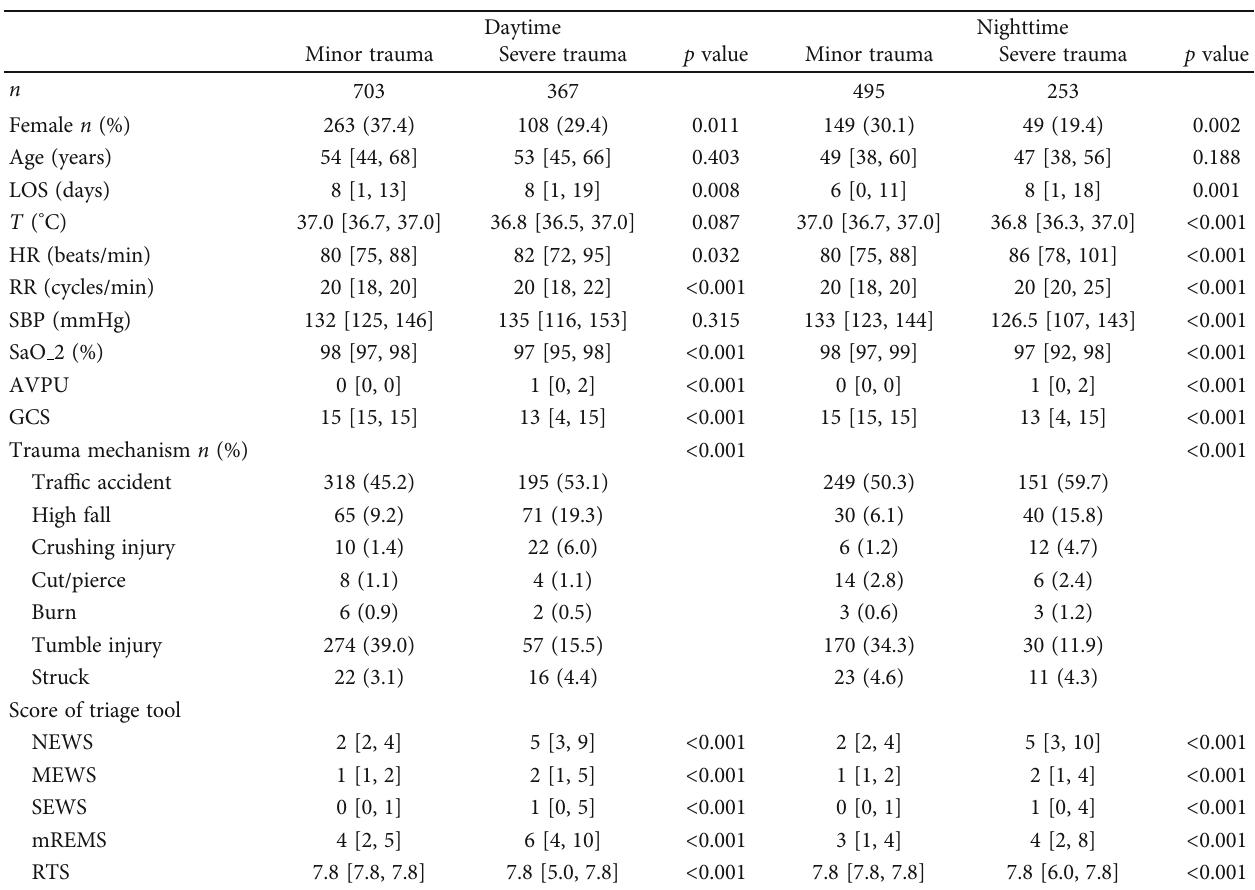
Table 3: Characteristics of the minor and severe trauma groups among patients with multiple trauma admitted during the daytime and nighttime.